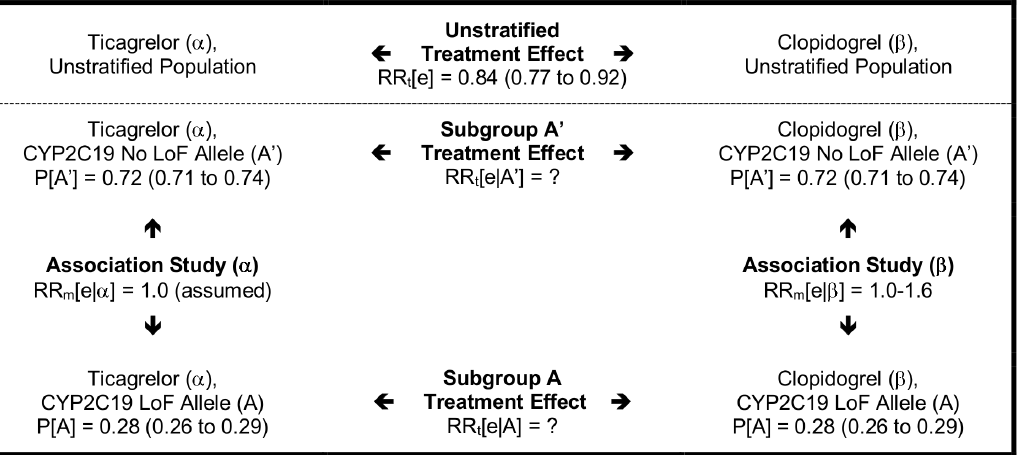
Figure 1. Relationships between subgroup treatment effects, association study results and unstratified RCT study results. CYP2C19 genotype and clopidogrel is used here as an example to illustrate the groups of individuals (based on treatment and pharmacogenomics marker status) involved in the indirect subgroup analysis and the relationships between the groups (both known and unknown). Values in the brackets represent the 95% confidence intervals for the estimate. CYP2C19: cytochrome P450 2C19, LoF: loss-of-function.